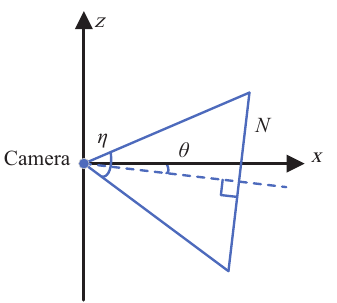
Figure 3. Relationship between θ and the intercept of the sea–sky line.